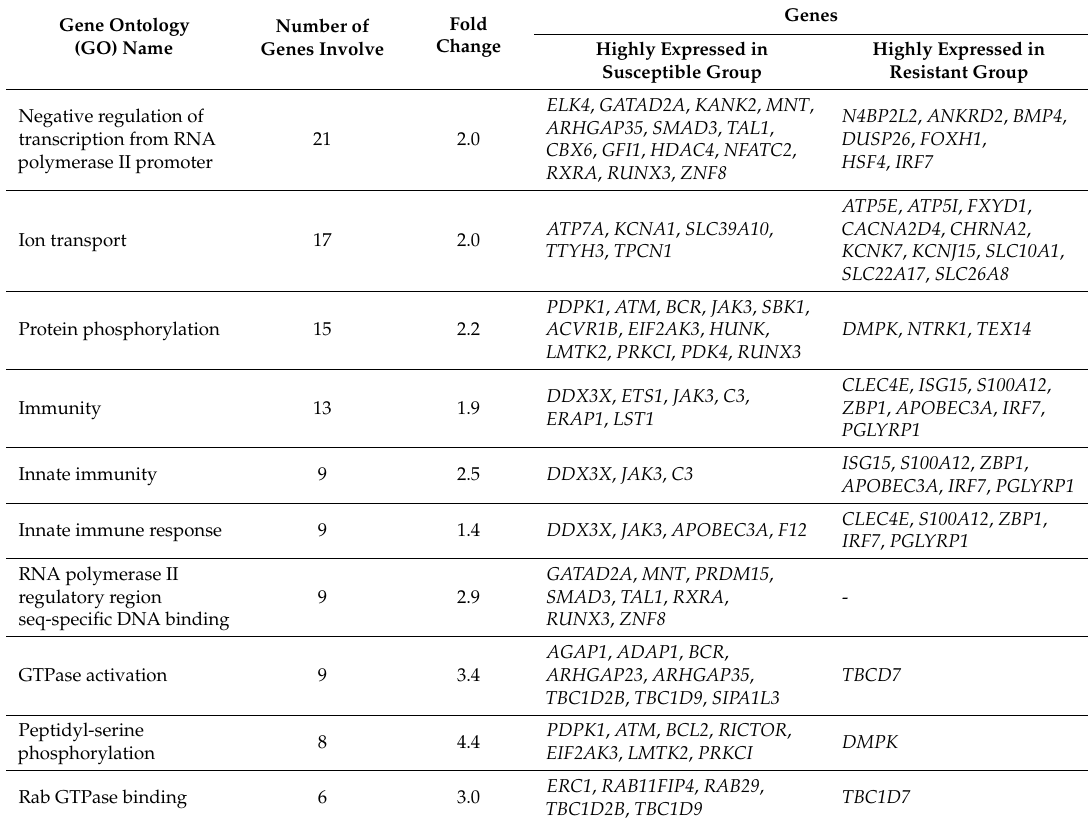
Table 3. Major functional annotation clusters (top 10 annotation clusters based on fold change (FC) and p < 0.05) in